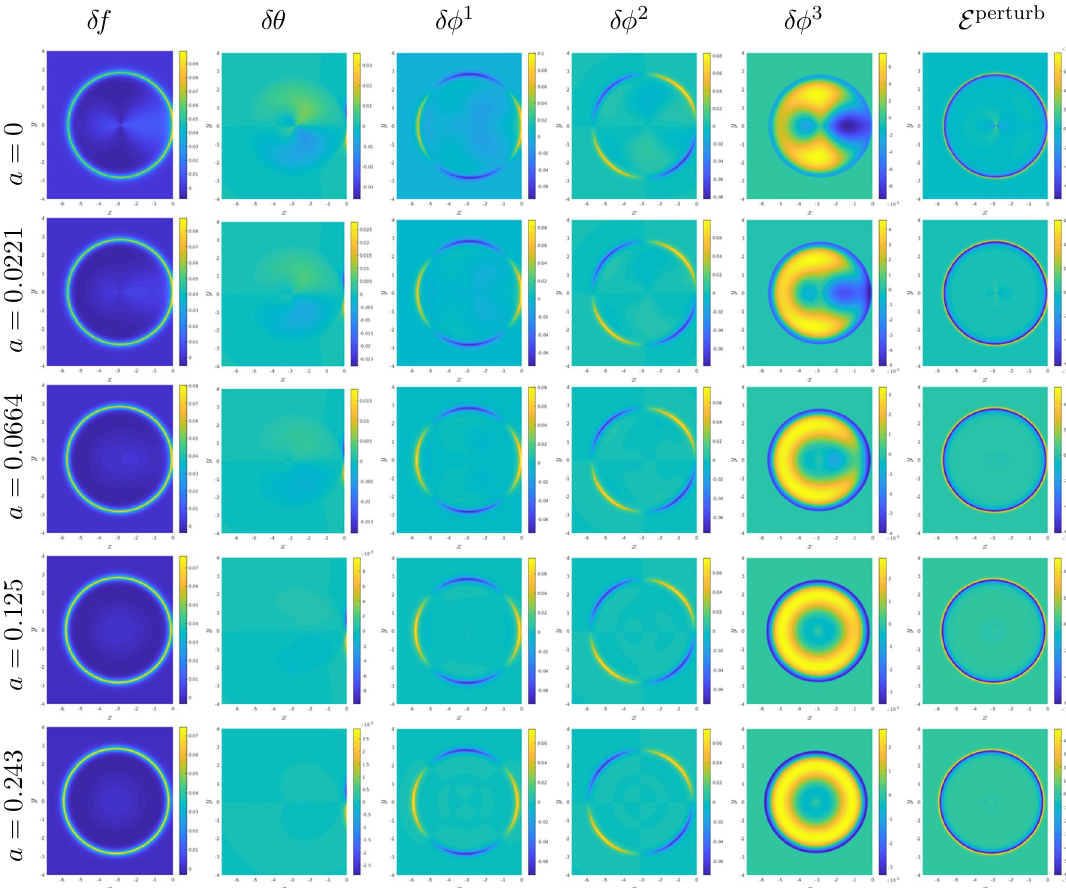
Figure 13 . Numerical solution for δf and δθ for two N = 2 compactons situated next two each other with separation distance 2 a for (cid:15) = 0 . 01 . Due to symmetry of the problem, only the left-hand side is calculated and shown. The gluing conditions (5.9) are imposed at x = 0 , which is located at the right-most part of every panel. Each row displays the perturbations δf , δθ , δφ 1 , δφ 2 , δφ 3 and the energy density of the perturbation E perturb , each in its column. Each panel is cropped so as to render the content as clear as possible; the left, top and bottom border do not represent the size of the